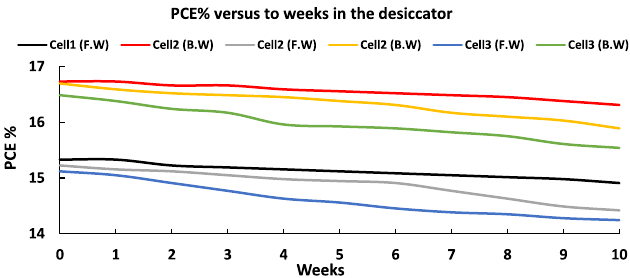
Fig. 8. Variations in the ef fi ciency of the perovskite solar cells measured over 70 days period in weekly intervals. Devices were kept in controlled desiccator for this part of the stability